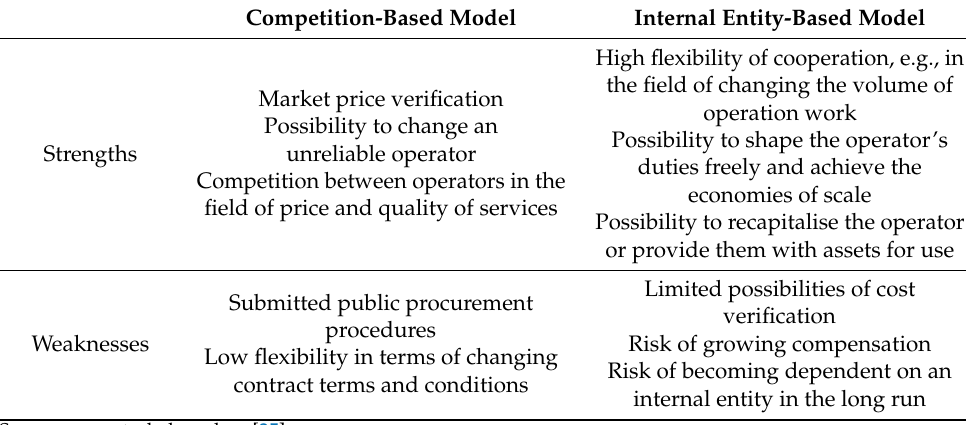
Table 2. Strengths and weaknesses of selected public transport market